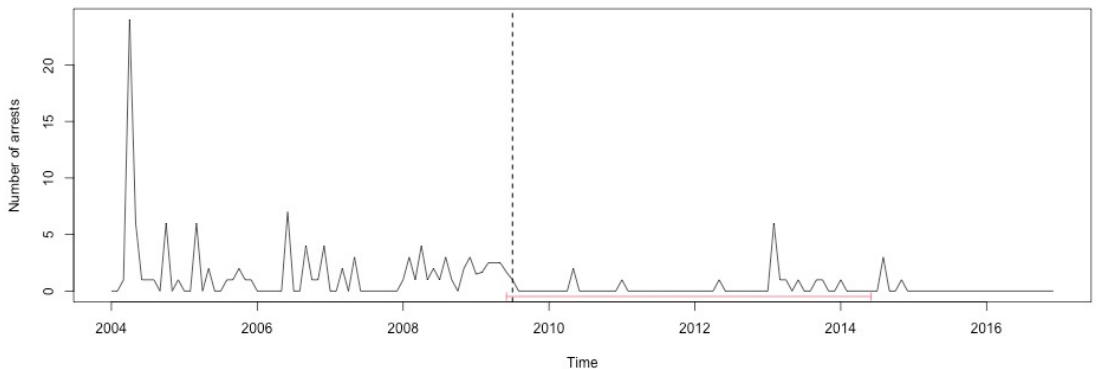
Figure A48. Heroin organized crime foreign nationals arrests 2004–2016 in the Czech Republic and structural breaks.